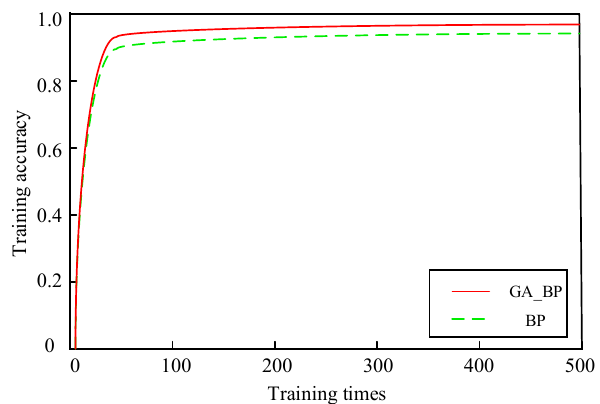
Figure 8. Comparison before and after neural network optimization.